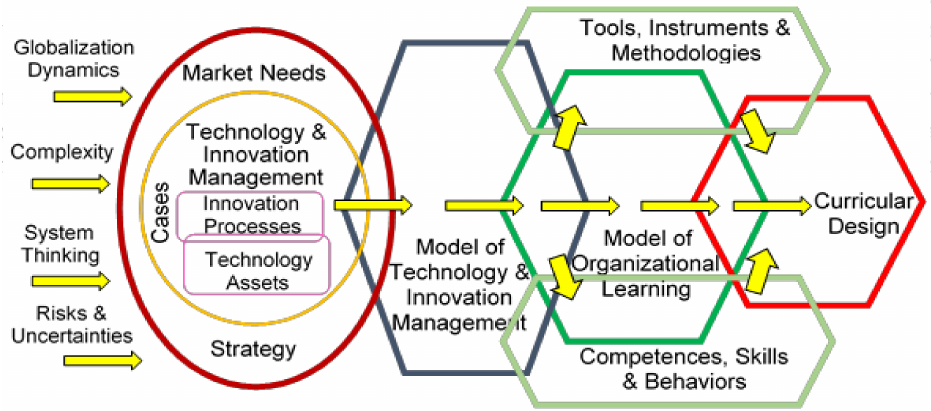
Figure 1. Approaches of the Study. Source: own